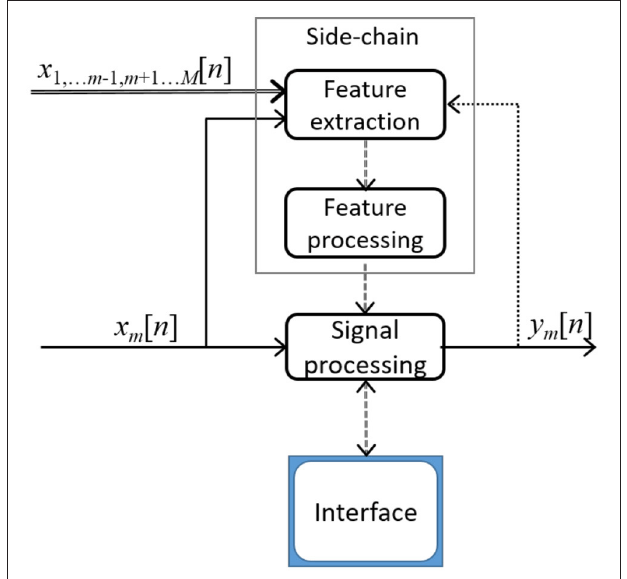
FIGURE 4 | The m th track of a cross-adaptive processing device with multitrack input, with optional feedback (dotted line).